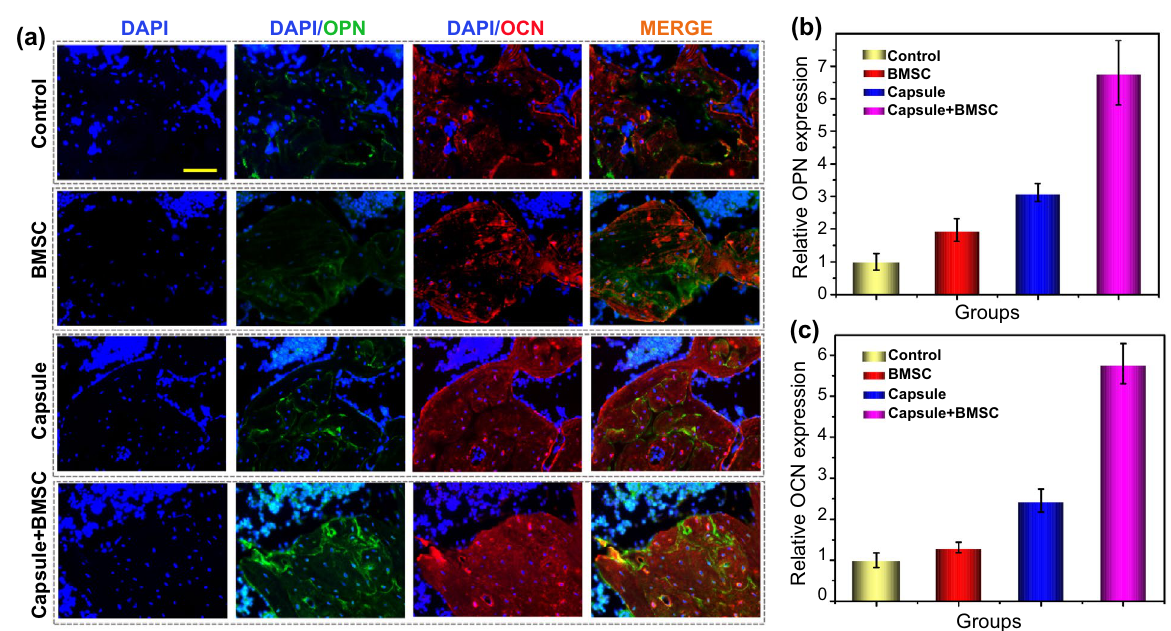
Fig. 6 Osteogenic protein expressions in different groups. a Representative OPN and OCN staining in different groups. b The relative OPN expression in different groups. c The relative OCN expression in different groups. The scale bar is 50 μm. OCN: osteocalcin; OPN: